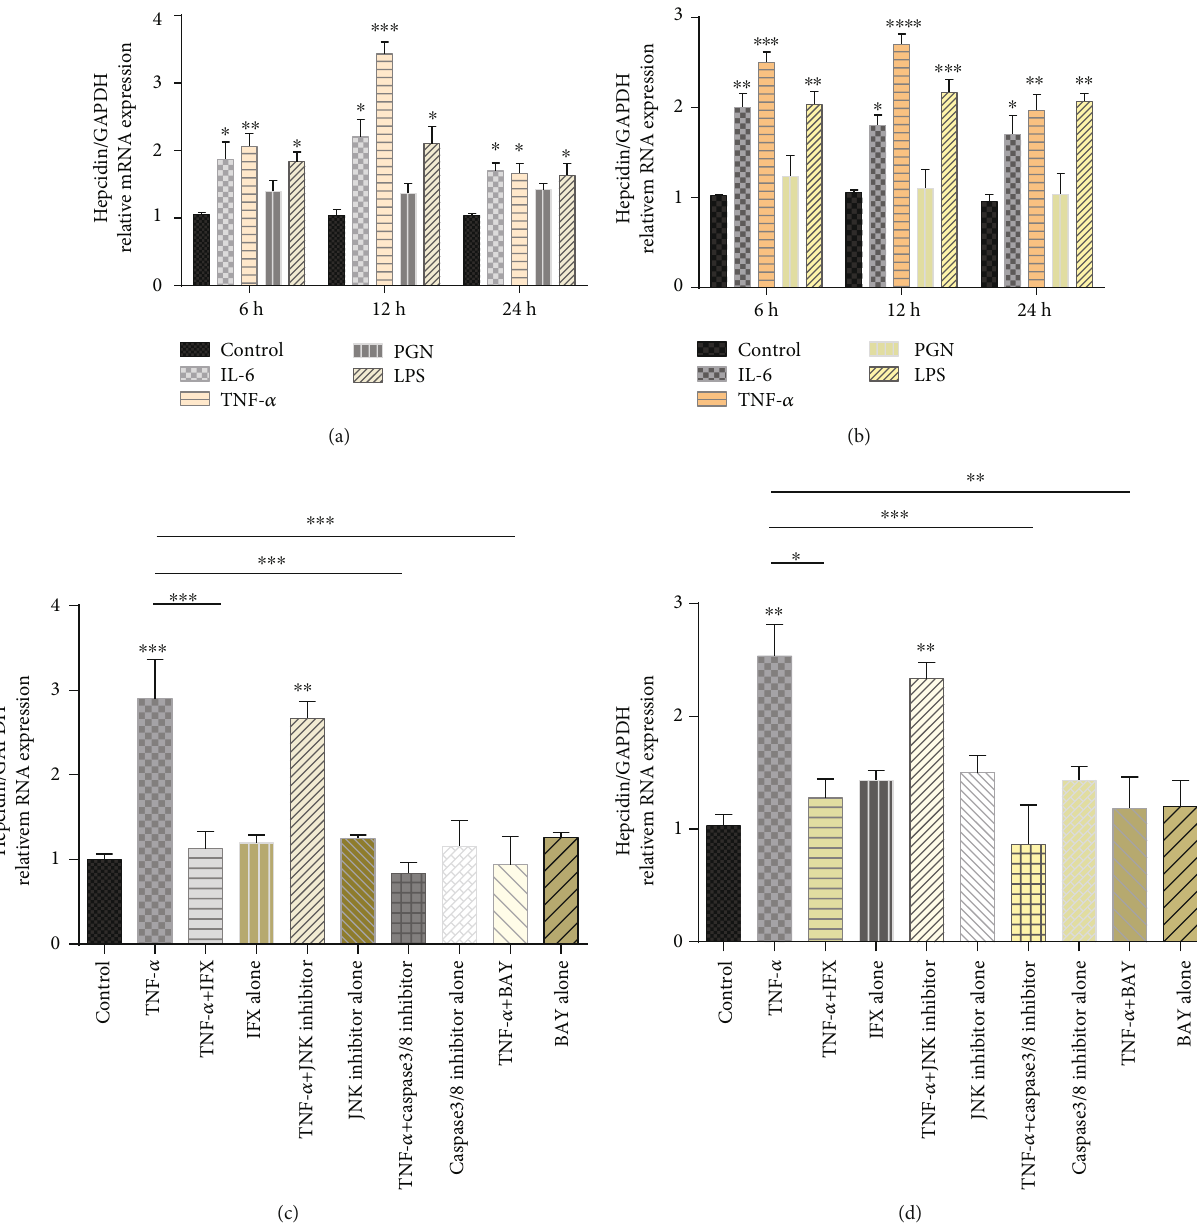
Figure 5: TNF- α upregulates hepcidin expression in liver cell line in caspase 3/8- and NF- κ B-dependent manners. (a) LO2 cell line and (b) HepG2 cell line were cultured in vitro and stimulated with IL-6 (10 ng/mL), TNF- α (10 ng/mL), PGN (100ng/mL), and LPS (100ng/mL), respectively. After 6, 12, and 24h of culture, cells were collected and the mRNA levels of hepcidin were determined by qRT-PCR. One-way ANOVA was performed for statistical analysis. ∗ P < 0 : 05 , ∗∗ P < 0 : 01 , ∗∗∗ P < 0 : 001 , and ∗∗∗∗ P < 0 : 0001 versus controls. (c) LO2 cell line and (d) HepG2 cell line were incubated with TNF- α (10ng/mL) in the presence of anti-TNF- α mAb (IFX, 50ng/ μ L), JNK inhibitor (JNK-IN-8, 10 μ M), NF- κ B inhibitor (BAY 11-7082, 10 μ M), and caspase-3/8 inhibitor (Z-DEVD-FMK, 50 μ M), respectively, as indicated. After 12 h of culture, cells were collected and qRT-PCR was used to determine mRNA levels of hepcidin expression. ∗∗ P < 0 : 01 , ∗∗∗ P < 0 : 001 . GAPDH mRNA levels in each sample were used to normalize gene expression, and the graph represents the combined data of 3 independent experiment ( N = 3 ) done each one in